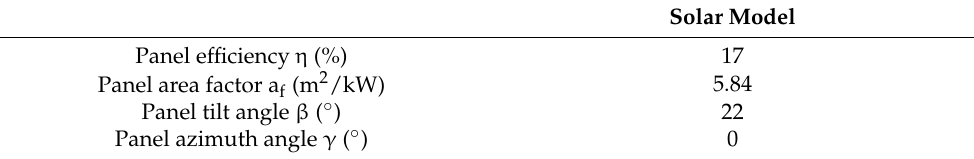
Table 2. Technology input data used for solar PV in this study calculated from data in [26,27].